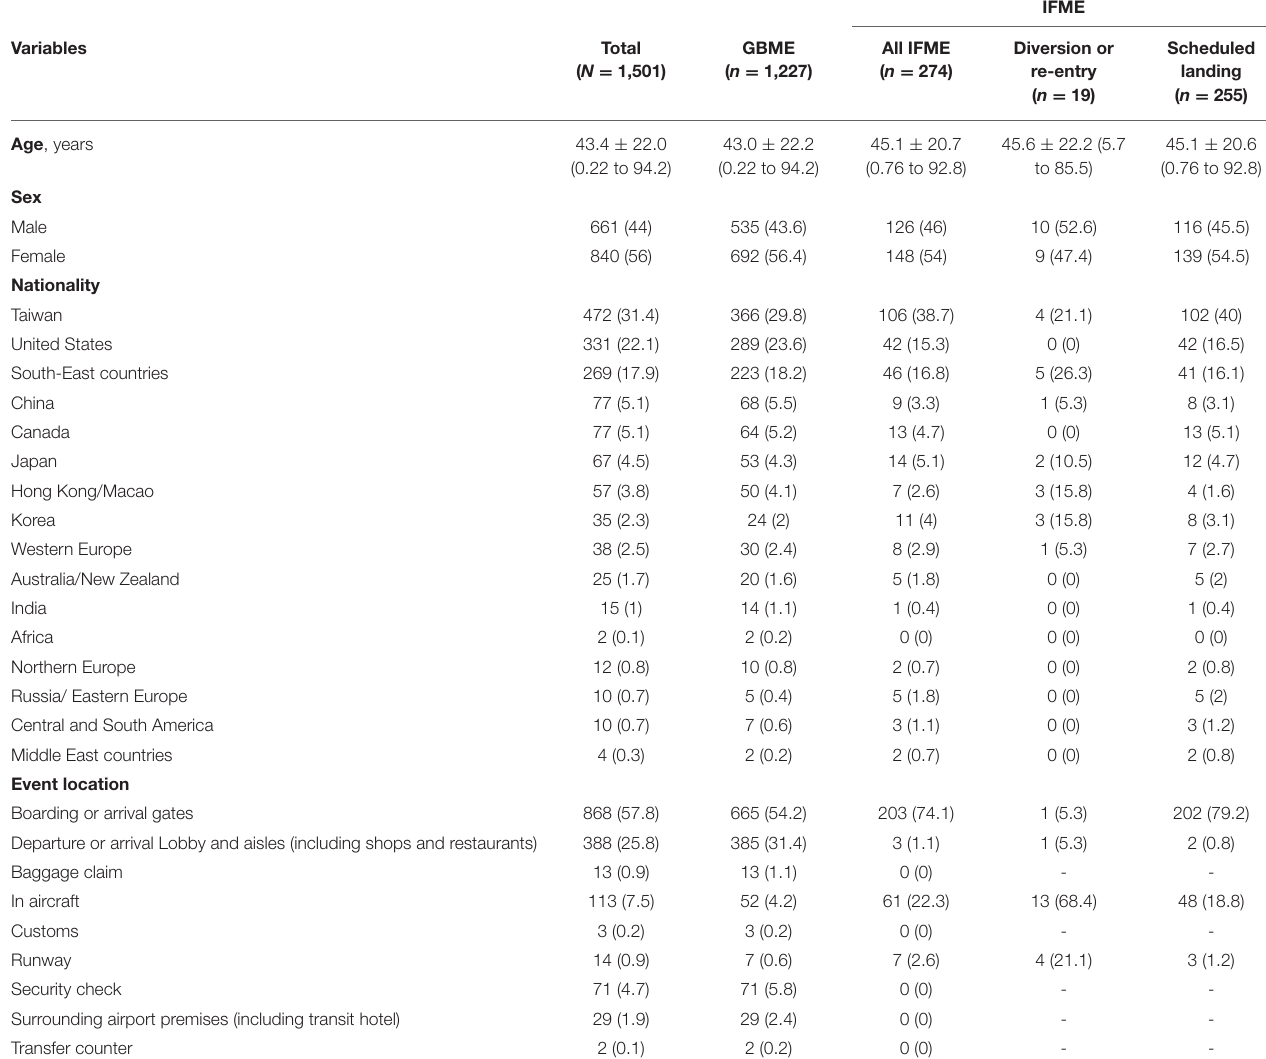
TABLE 1 | Patients’ characteristics at end of study